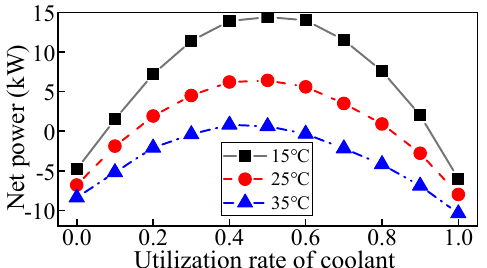
Figure 7. Under 15 ◦ C, 25 ◦ C and 35 ◦ C system power changes with the utilization rate of coolant under F working